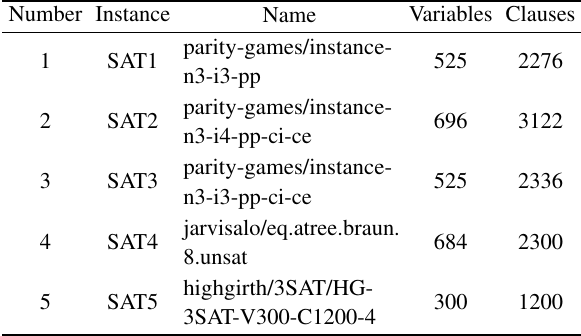
Table 2 Boolean satisfiability problems instance.